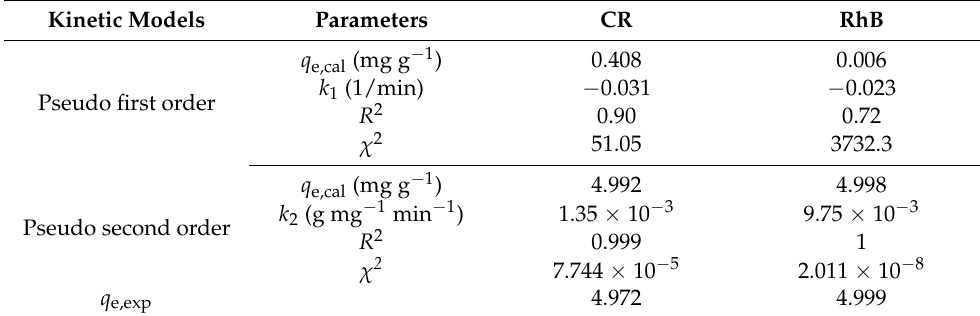
Table 3. Adsorption kinetics parameters calculated for RhB and CR dyes adsorbed on PTFAC*. Kinetic Models Parameters CR RhB